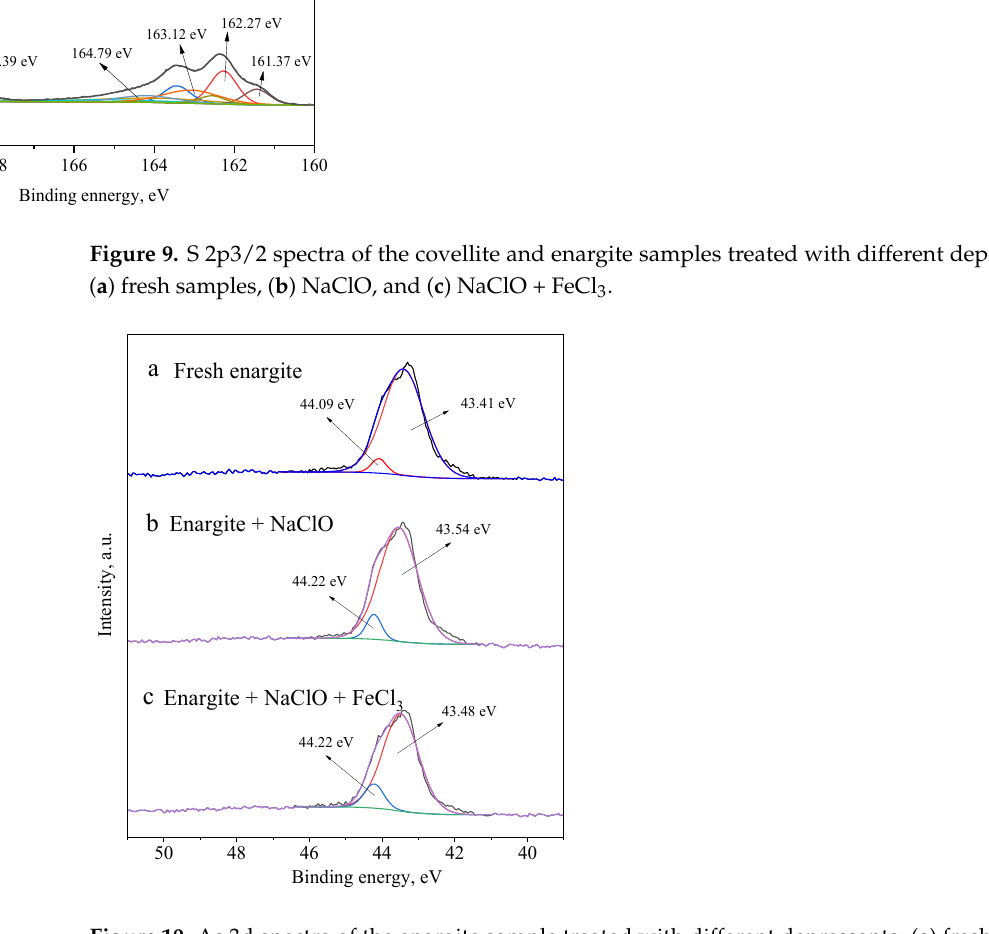
Figure 10. As 3d spectra of the enargite sample treated with different depressants: ( a ) fresh sample, ( b ) NaClO, and ( c ) NaClO + FeCl 3